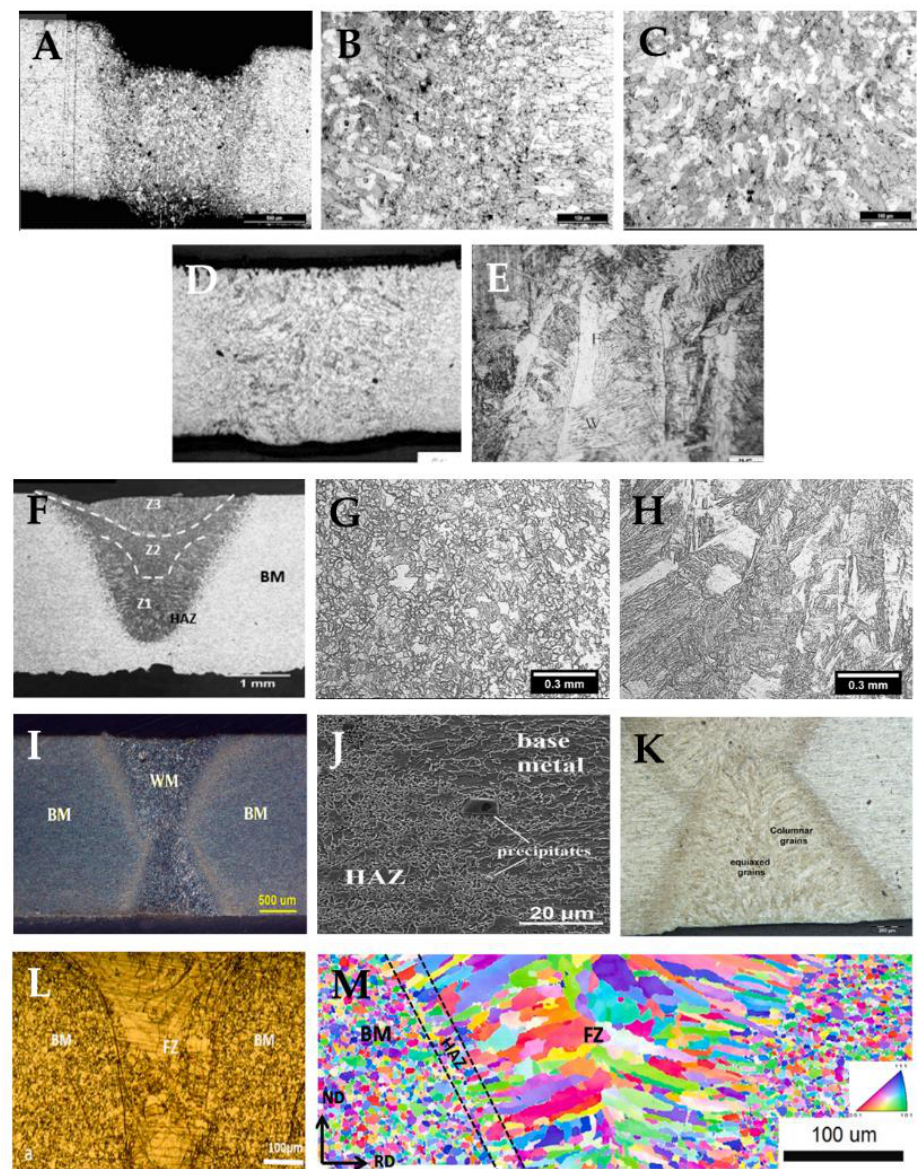
Figure 7. Pulsed laser weldments made of low alloy and carbon steels: St37 steel ( A ), and its heat- affected zone (HAZ) ( B ) and FZ ( C ) [52]; St14 steel ( D ), and its FZ ( E ) [53]; AISI 1005 ( F ), and its HAZ ( G ) and FZ ( H ) [21]; S700MC steel ( I ), and its HAZ ( J ) and FZ ( K ) [54]; and twinning induced